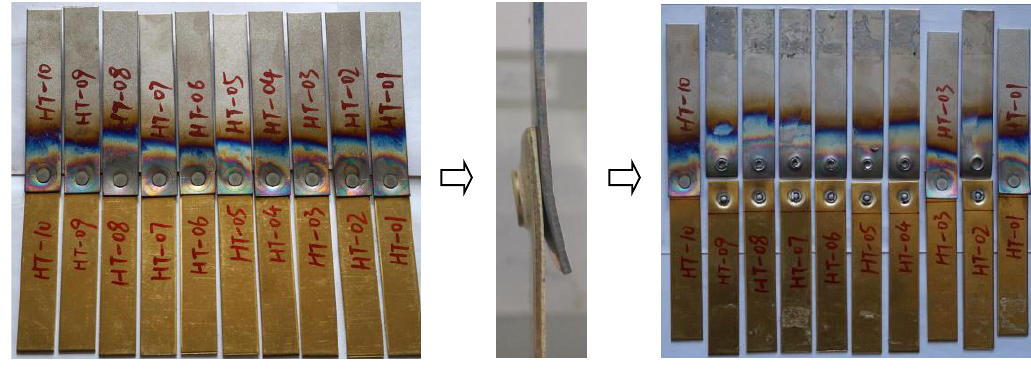
Figure 4. Tensile process of the STH joints.